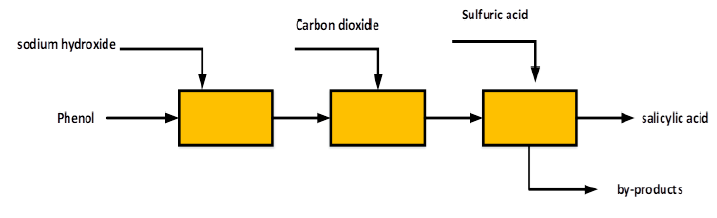
Figure 1. Production of salicylic acid by the Kolbe–Schmitt